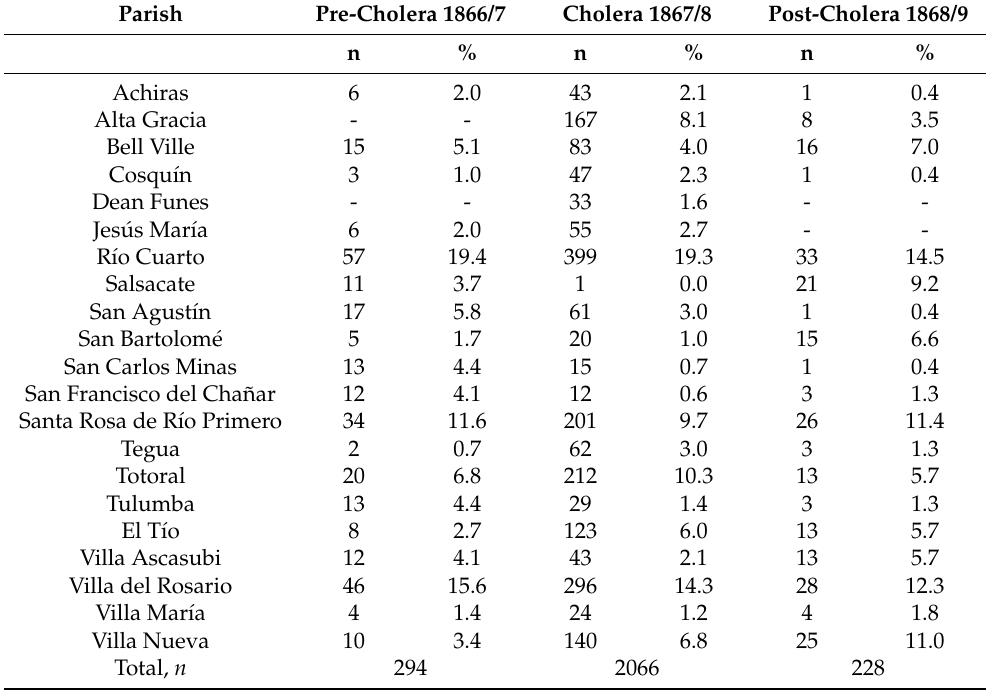
Table 2. Percentage of deaths according to the distribution by parishes.